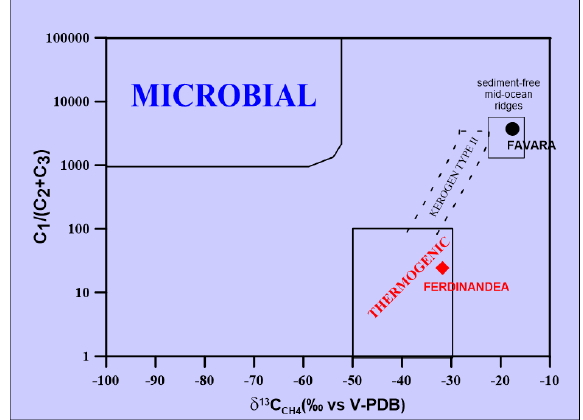
Figure 11. Bernand diagram modified after Tassi et al. [2012]. Methane emitted from the vent close to the Graham Bank (red di- amond) is thermogenic in origin and is genetically different from that released from the Favara from Pantelleria Island (black dot) (data from Tassi et al.